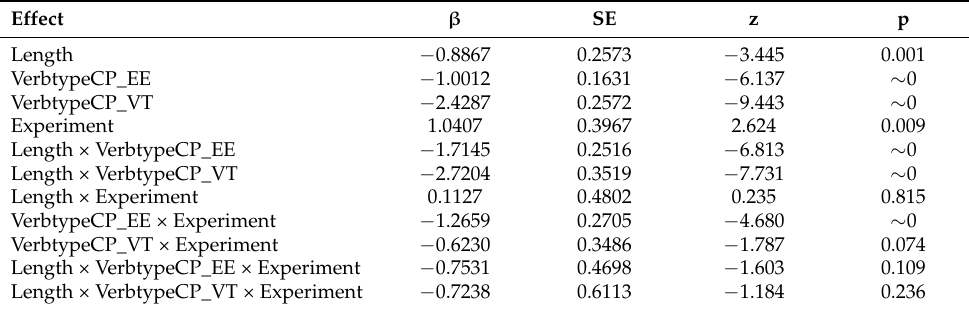
Table A22. Coefficient estimates for combined Experiment 2 and 3 mixed-effects